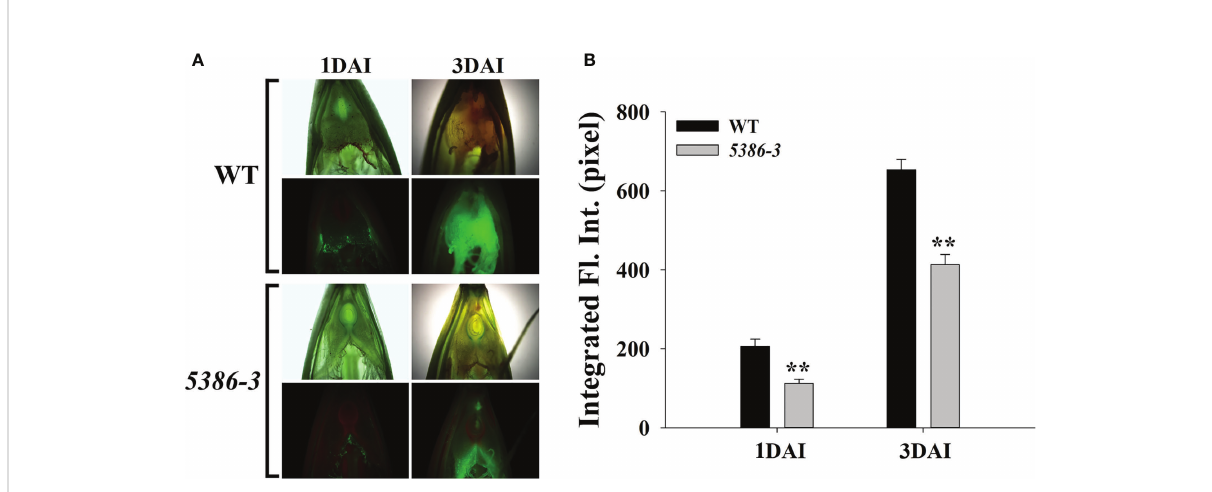
FIGURE 10 Phenotype differences between inoculated (F) graminearum in spikes between WT and LMM 5386 lines. (A) Green fl uorescence phenotype 1 day after inoculation (DAI) and 3 DAI. (B) Integrated fl uorescence intensity (IFI) at 1 DAI and 3 DAI. Values are means ± SD based on thirty replicates. Error bars indicate standard deviations. **P <